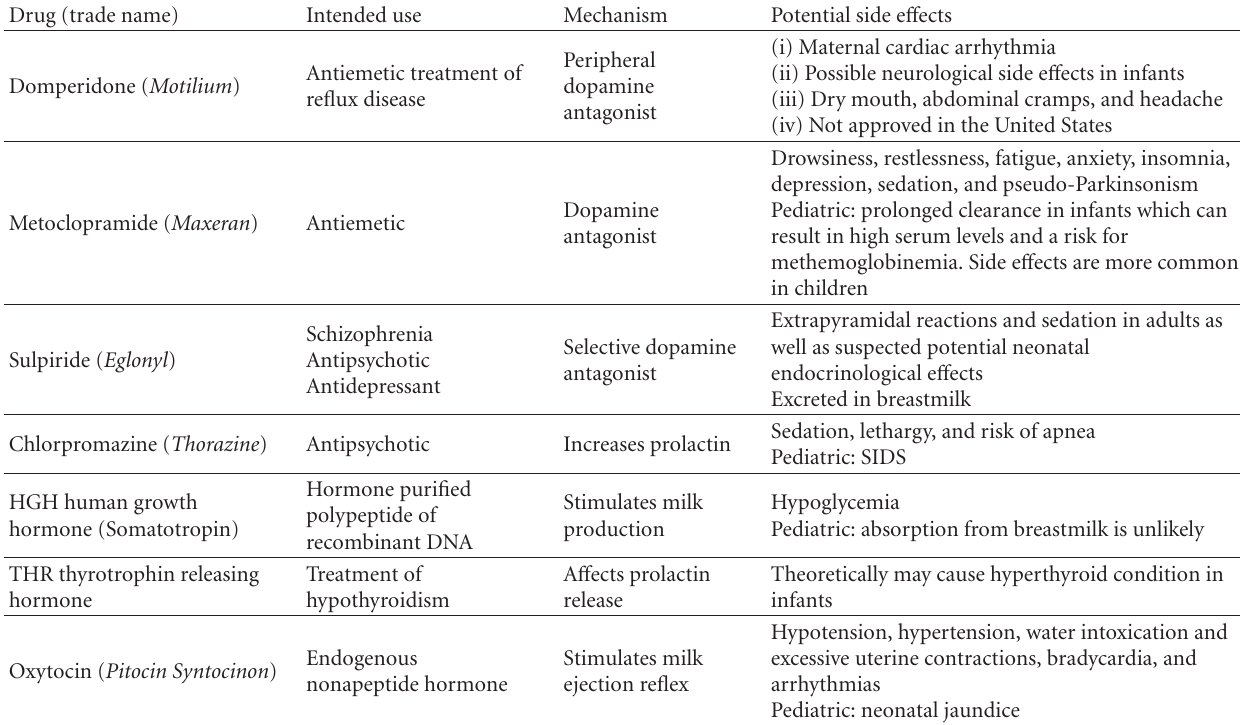
Table 1: Prescription drugs used to increase breastmilk